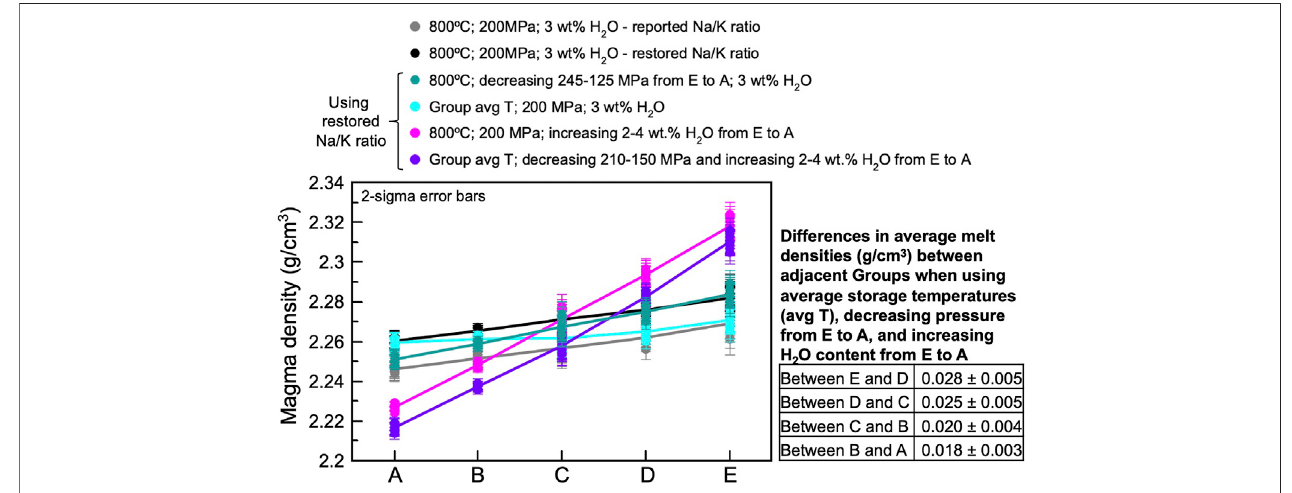
FIGURE 10 | Melt densities of average Rattlesnake Tuff Group compositions calculated when altering pressure, temperature, and water content conditions using the DensityXcalculator byIacovinoand Till(2019).Lines connecttheaveragedensity among each Groupinthegiven conditionstohighlighttheoveralltrendbetweenall Groups. Black and grey data represent Group densities calculated given the same pressure, temperature, and water content conditions, but grey data use the originally reported Na 2 O and K 2 O values, and black data use compositions with the restored (1:1) Na/K ratios. Purple data represent calculated densities using all the available pressure, temperature, and water content data, and are thus considered the most accurate densities for all Groups.